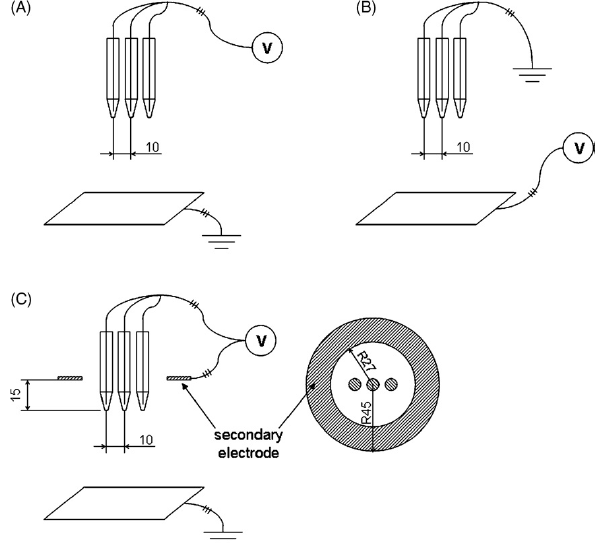
Figure 9: Scheme of multi-jet electrospinning setups: (a) electrically charged solution and grounded collector, (b) electrically charged tion and grounded collector with secondary electrode